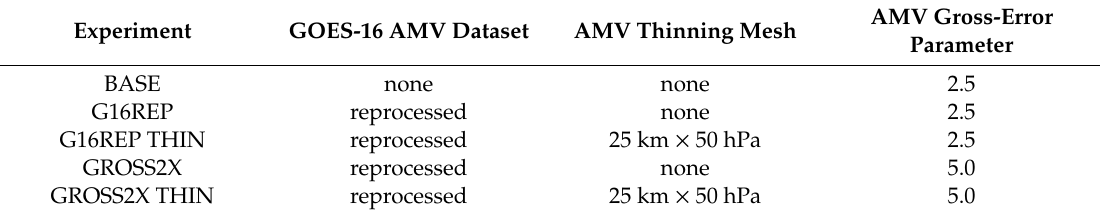
Table 1. Configuration of the HWRF GOES-16-enhanced AMV assimilation experiments.